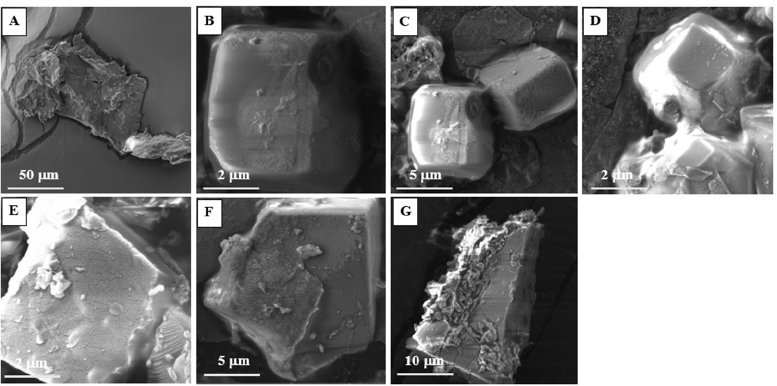
Figure 11. SEM photomicrographs of PEtOx powder before and after incubating in SLF at different time intervals ( A ) PEtOx original powder ( B ) PEtOx 1 week ( C ) PEtOx 2 weeks ( D ) PEtOx 3 weeks ( E ) PEtOx 4 weeks ( F ) PEtOx 5 weeks ( G ) PEtOx 6 weeks.